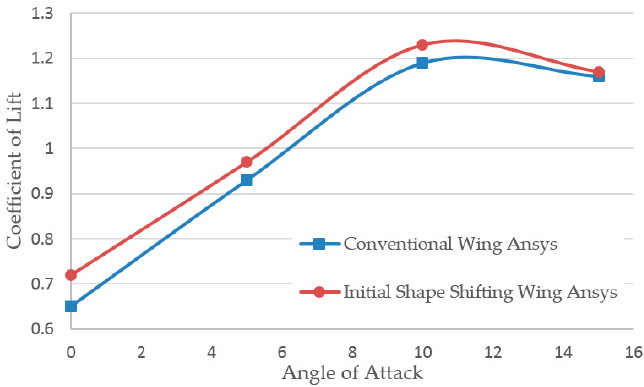
Figure 16. A graph showing the coefficient of lift results generated from Ansys for the conventional wing and initial morphing wing.